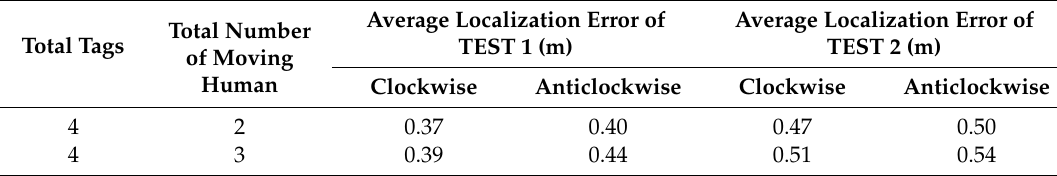
Table 4. Impact of Number of Moving objects in test